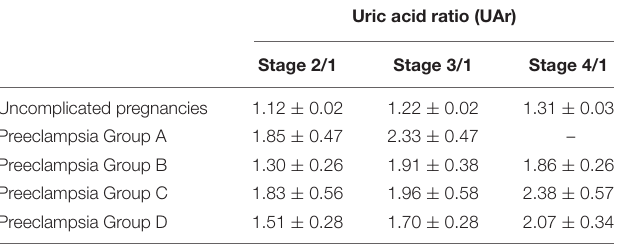
TABLE 5 | Uric acid ratio (UAr) in women who developed different presentations of